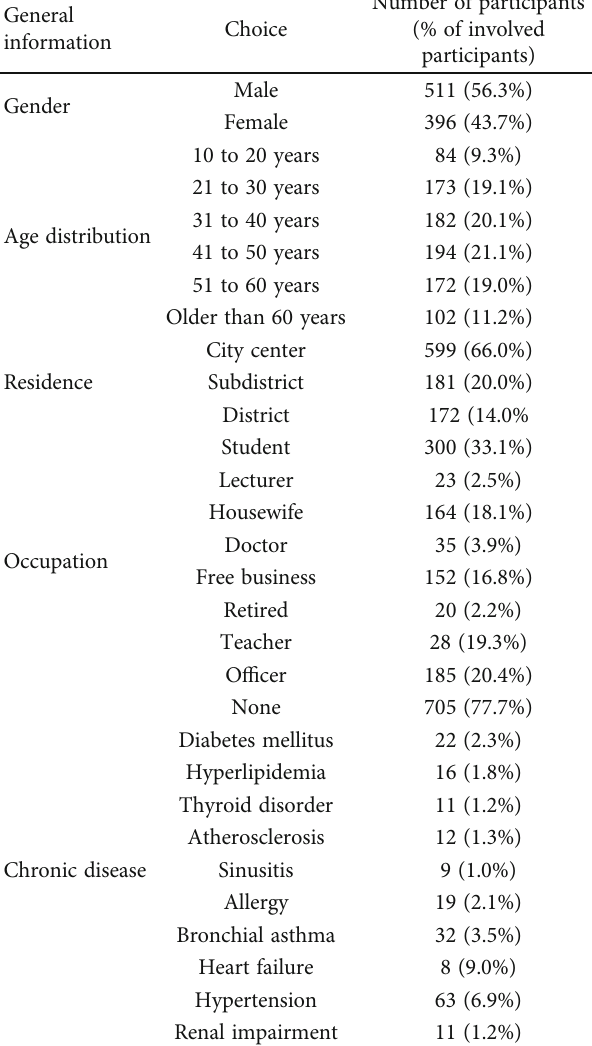
Table 1: General sociodemographic information of research